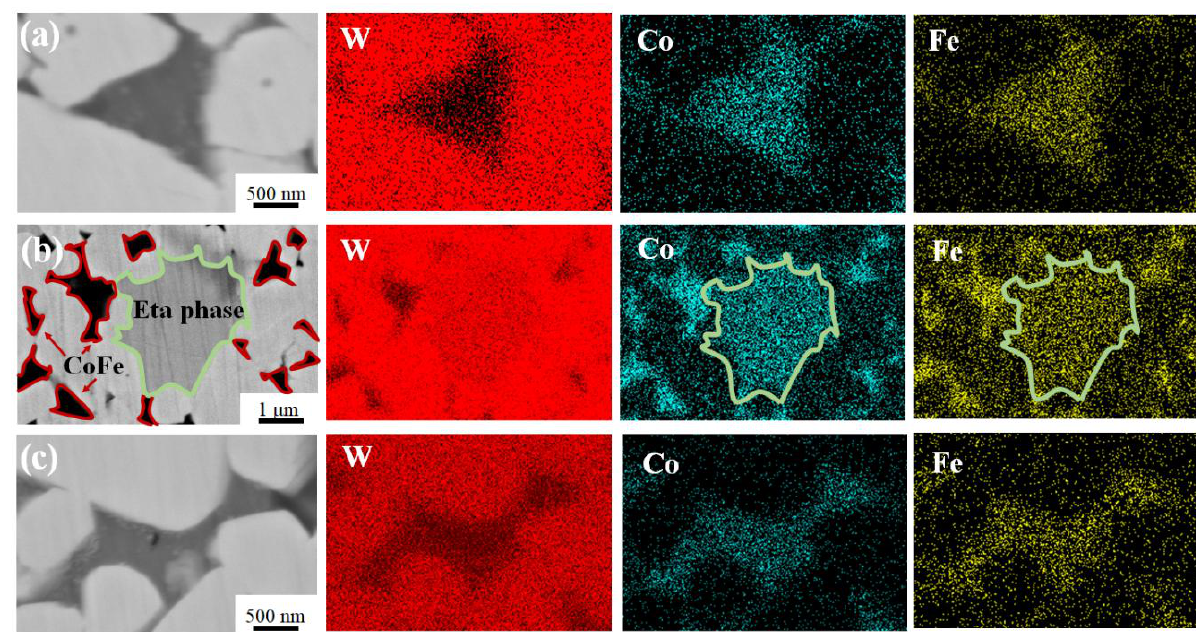
Figure 6. EDS mapping of element distribution of different samples, ( a ) the binder phase of 2Fe–5.3C sample, ( b ) the binder and eta phases of 2Fe–5.3C sample, ( c ) the binder phase of 2Fe–6.3C sample.